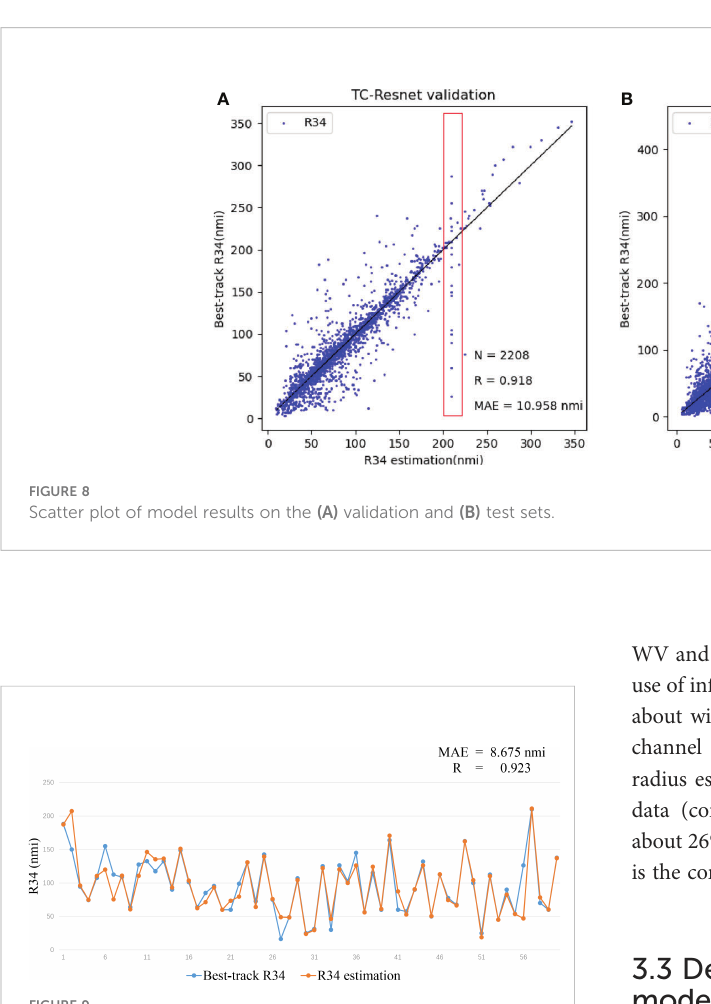
FIGURE 9 Comparison of predicted results and labeled values for 60 randomly selected test sets.